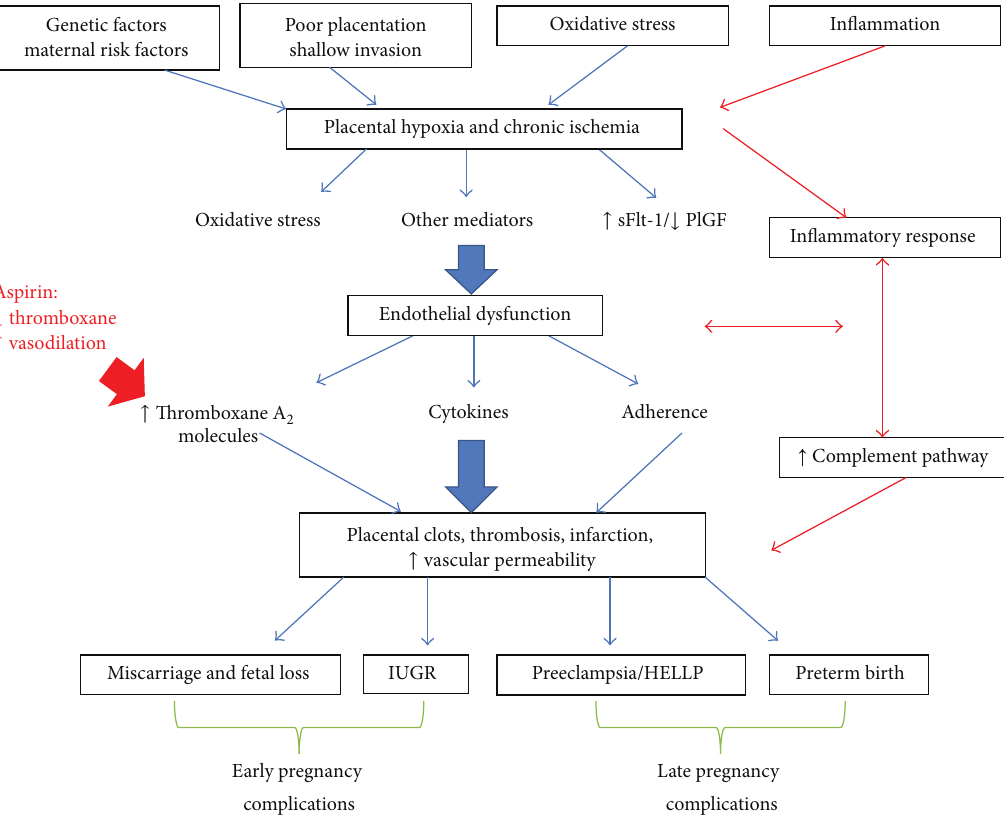
Figure 1: Mechanisms of